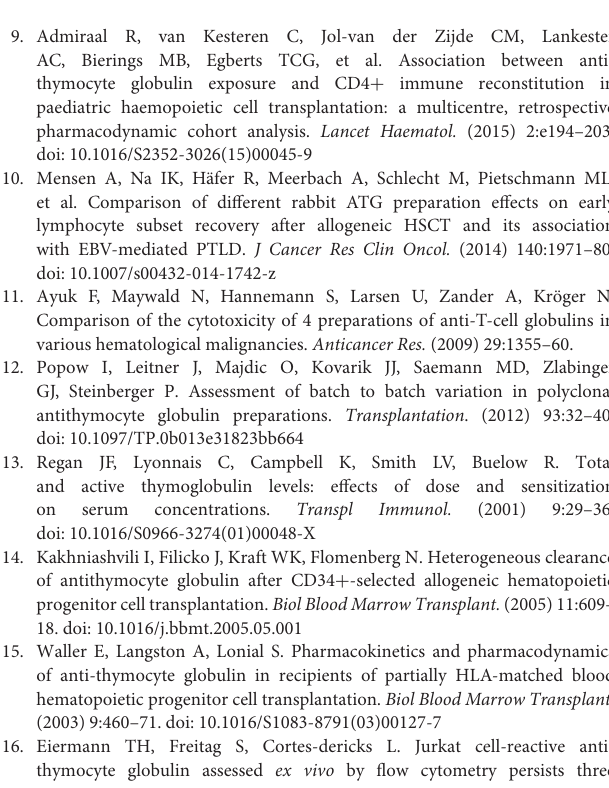
range of concentrations of active ATG the results showed a good correlation for both products using either HUT-78 or T-cells in PBMC as target. Supplementary Figure 2 | The effect of lymphocytes pre start serotherapy and the total nucleated cell dose in the graft on the active ATG level. (A) No relation between the number of lymphocytes pre start serotherapy and active ATG level at the day of transplantation was observed in this acute leukemia patient cohort. (B) Patients were ordered based on the brand of ATG, the dose of ATG and the amount of nucleated cells in the graft, creating 6 different groups. The ATG-Genzyme high (10 mg/kg) and low (6–8 mg/kg) dosage treated patients getting a high number of nucleated cells, received a comparable number of nucleated cells as the Fresenius (both high 60 mg/kg and low 45 mg/kg) treated patients. (C) Factor of decrease of the active-ATG level at week 1 vs. 0 (day of transplantation) was highest in the Fresenius groups and was significantly different between the 4 ATG groups containing patients that received high numbers of nucleated cells (Kruskal-Wallis test: p = 0.0018). No significant difference in the decrease of this factor (ns, Genzyme 10 mg/kg group low vs. high NC: p = 0.536, Genzyme 6–8 mg/kg group low vs. high NC: p = 0.231) was observed in the ATG-Genzyme treated groups between patients that received a low or a high number of nucleated cells. Supplementary Figure 3 | The effect of TBI on T-cell recovery. No significant difference in T-cell recovery at 1, 2, and 3 months post-HSCT was observed between patients treated with or without TBI in the conditioning regimen. The Genzyme-low group was left out of this analysis since only one patient in this group received TBI. Figure shows geomeans and 95% confidence interval. Supplementary Figure 4 | The effect of ATG brand and dosing on clinical outcome parameters. No significant difference was observed between the ATG-Fresenius and the two ATG-Genzyme groups for CMV and EBV infection/reactivation (up to 6 months after HSCT), relapse of the acute leukemia or for overall survival (up to 5 years post-HSCT). For CMV and EBV only patients at risk (numbers in the table below the graph) were included in the